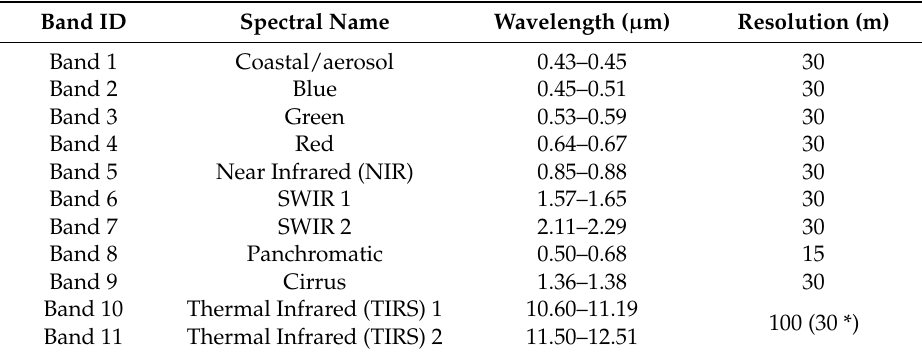
Figure 2. A false color image of combining Bands 4, 3 and 2 (RGB) of the OLI data at 15-m resolution, acquired on 30 November 2014. The blue lines are overlaid tidal cracks identified visually in the image, the lines with number labels (6 lines) are cracks confirmed based on field observations conducted on 30 and 31 October 2014. Table 1. OLI and TIRS Bands of Landsat 8.